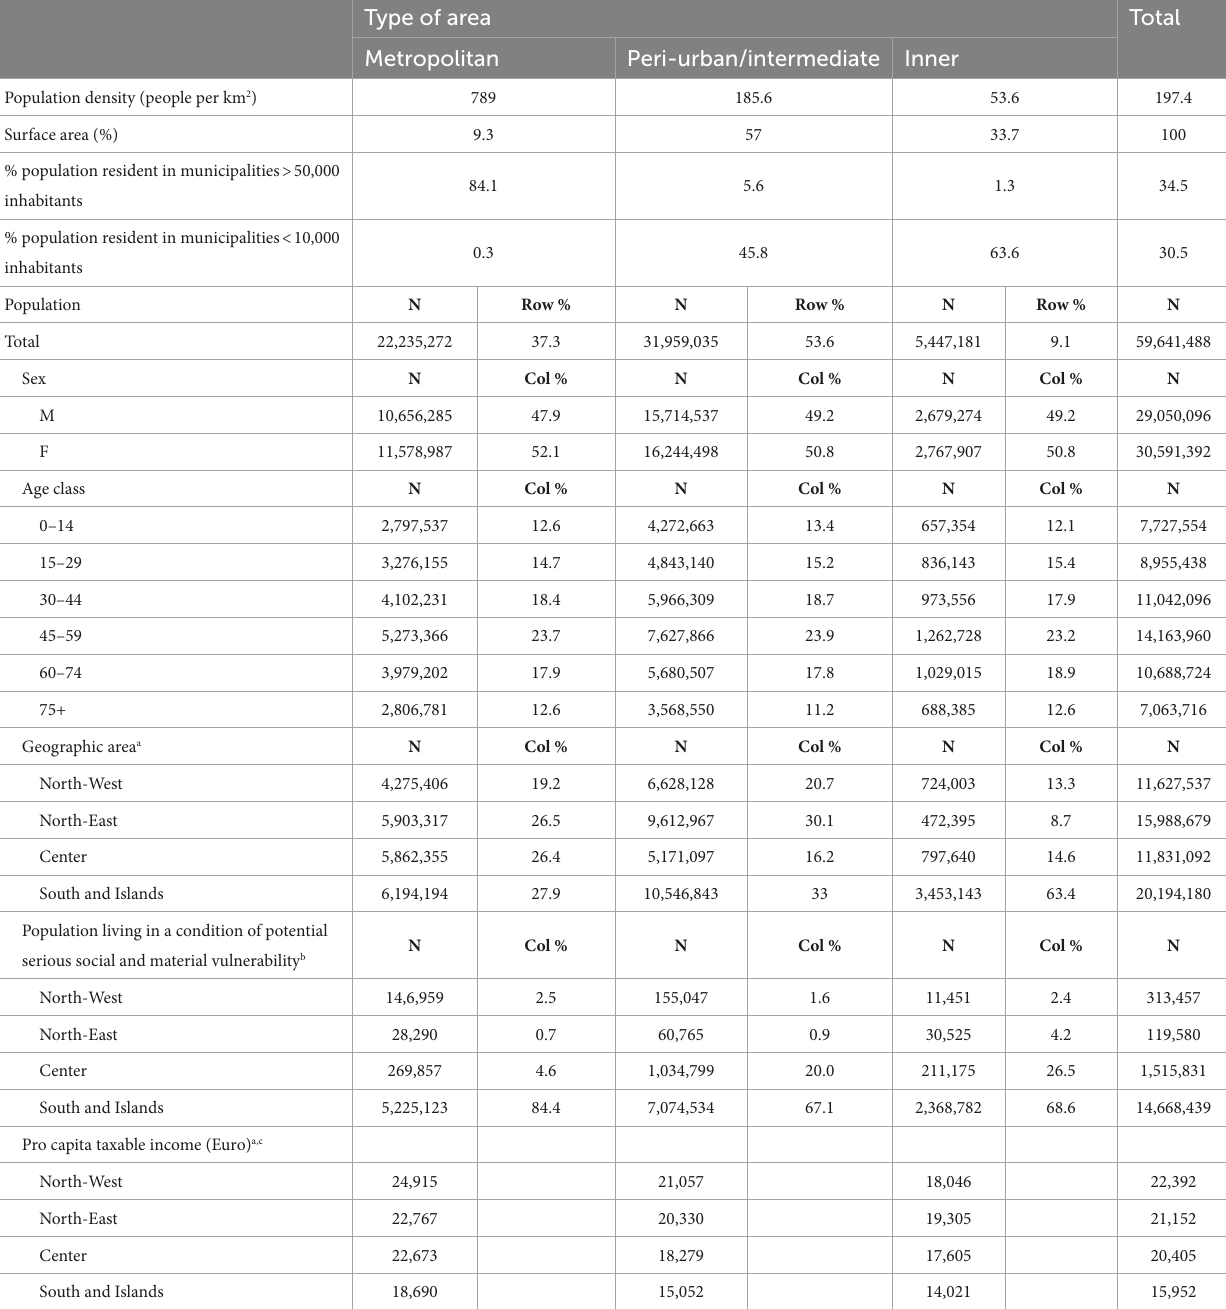
TABLE 1 Demographic and territorial characteristics of the resident population of metropolitan areas, peri-urban/intermediate and inner